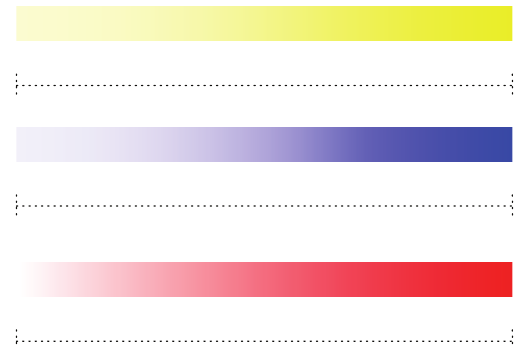
Figure 1: Visual analogue scale (VAS) for the assessment of subjective impression of sound richness of each musical stimulus. The length of color bar is 140mm.